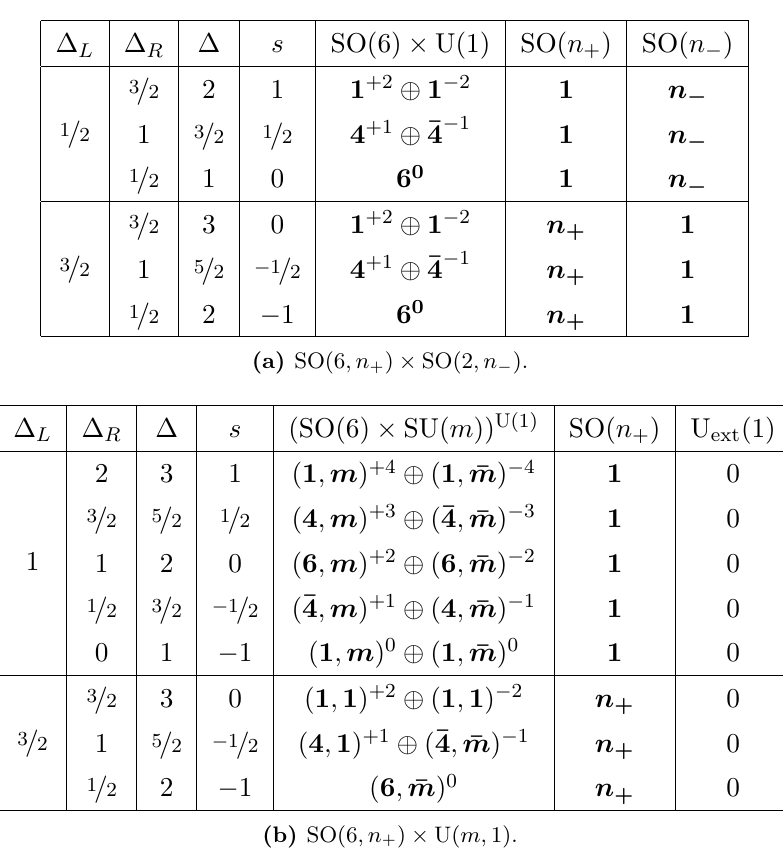
= 0 MNPQ = 2. (cid:0) . (cid:0) q (cid:0) r (cid:0) s (cid:0)